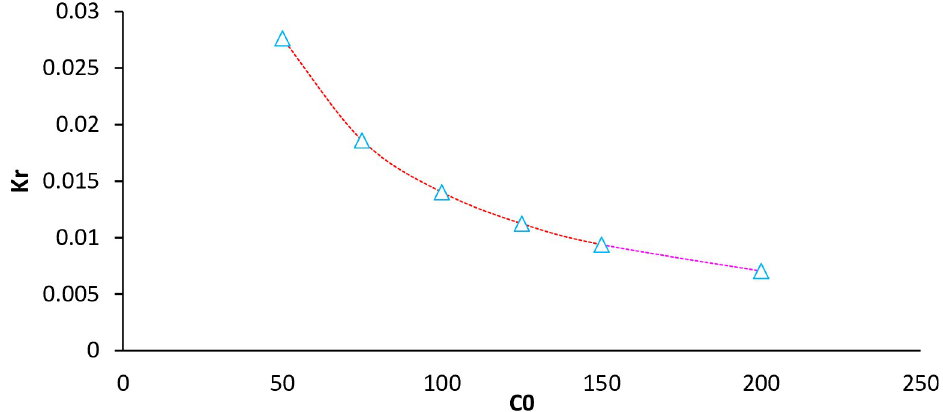
Fig 8. Plot of Kr versus CIP